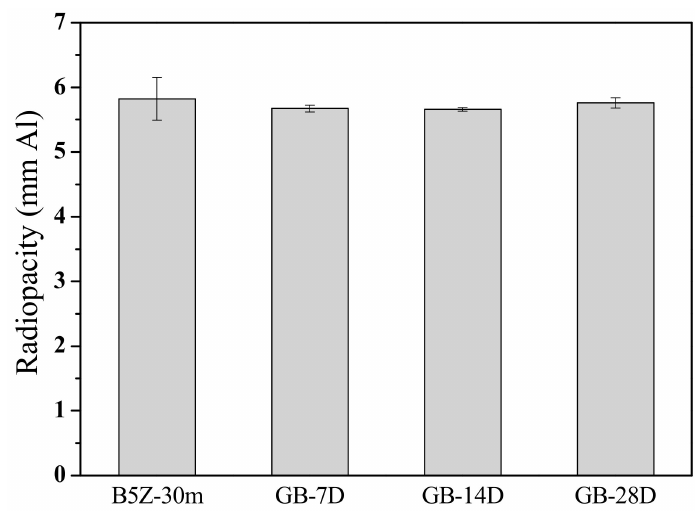
Figure 8. Radiopacity of MTA-like cements stored in a glove box for 7, 14, and 28 days (i.e., GB-7D, 14D, and 28D, respectively). Table 2. Radiopacity for MTA-like cements prepared by 30 min as-milled (Bi 2 O 3 ) 95 (ZrO 2 ) 5 powder (coded as B5Z-30m) and stored at ambient (AT), dry box (DB), and glove box (GB)